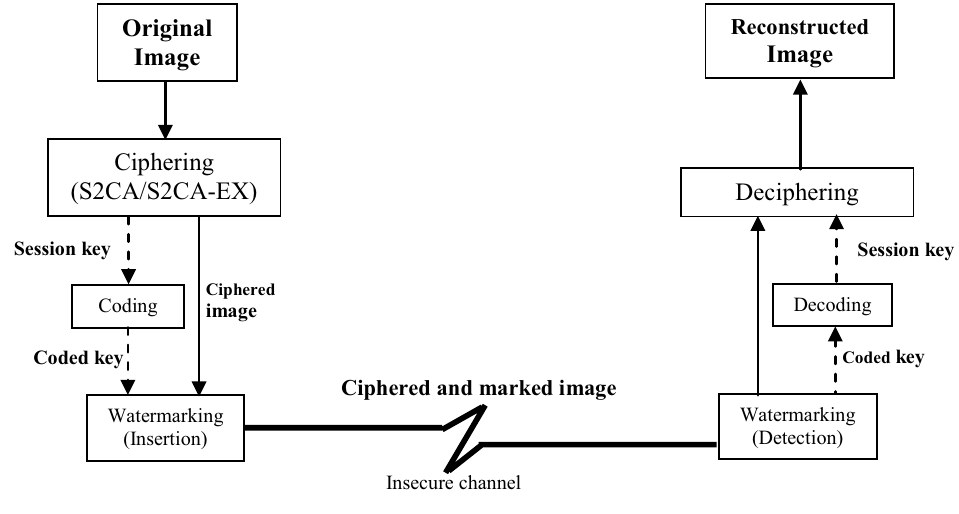
Fig. 17. General scheme of the ciphering process and generated key secure transmission by